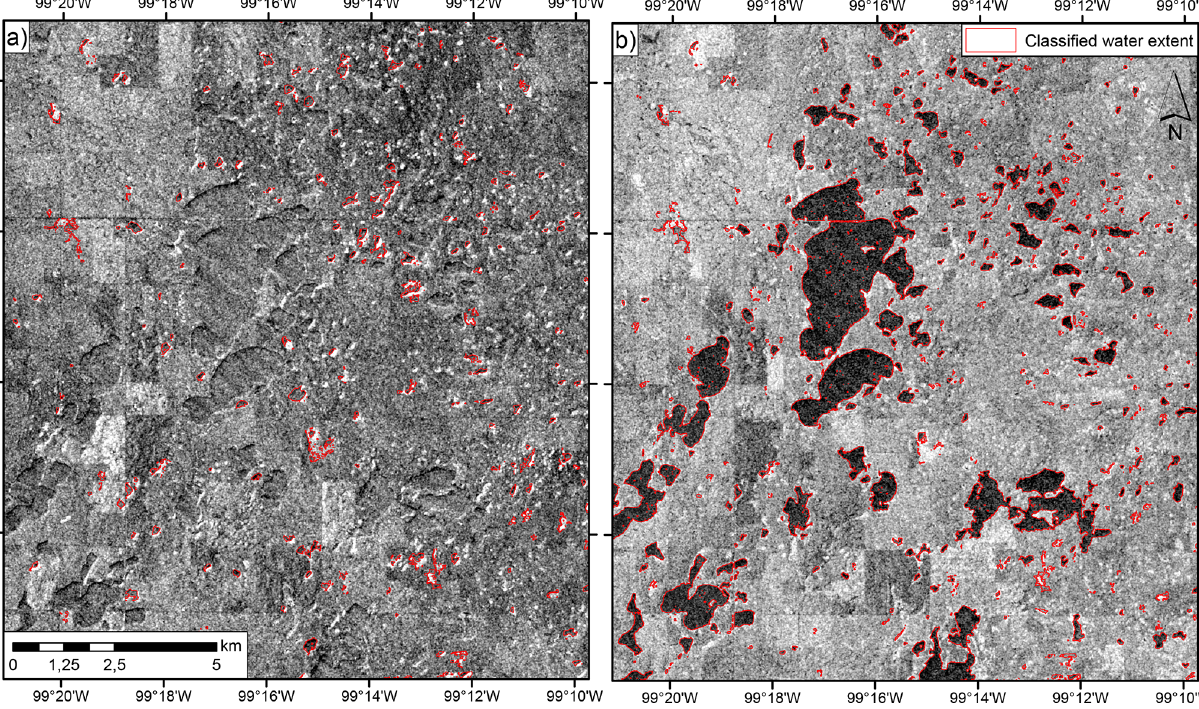
Figure 7. Backscatter in (a) VV and (b) VH polarisation as well as derived waterbodies on 12 October 2019.